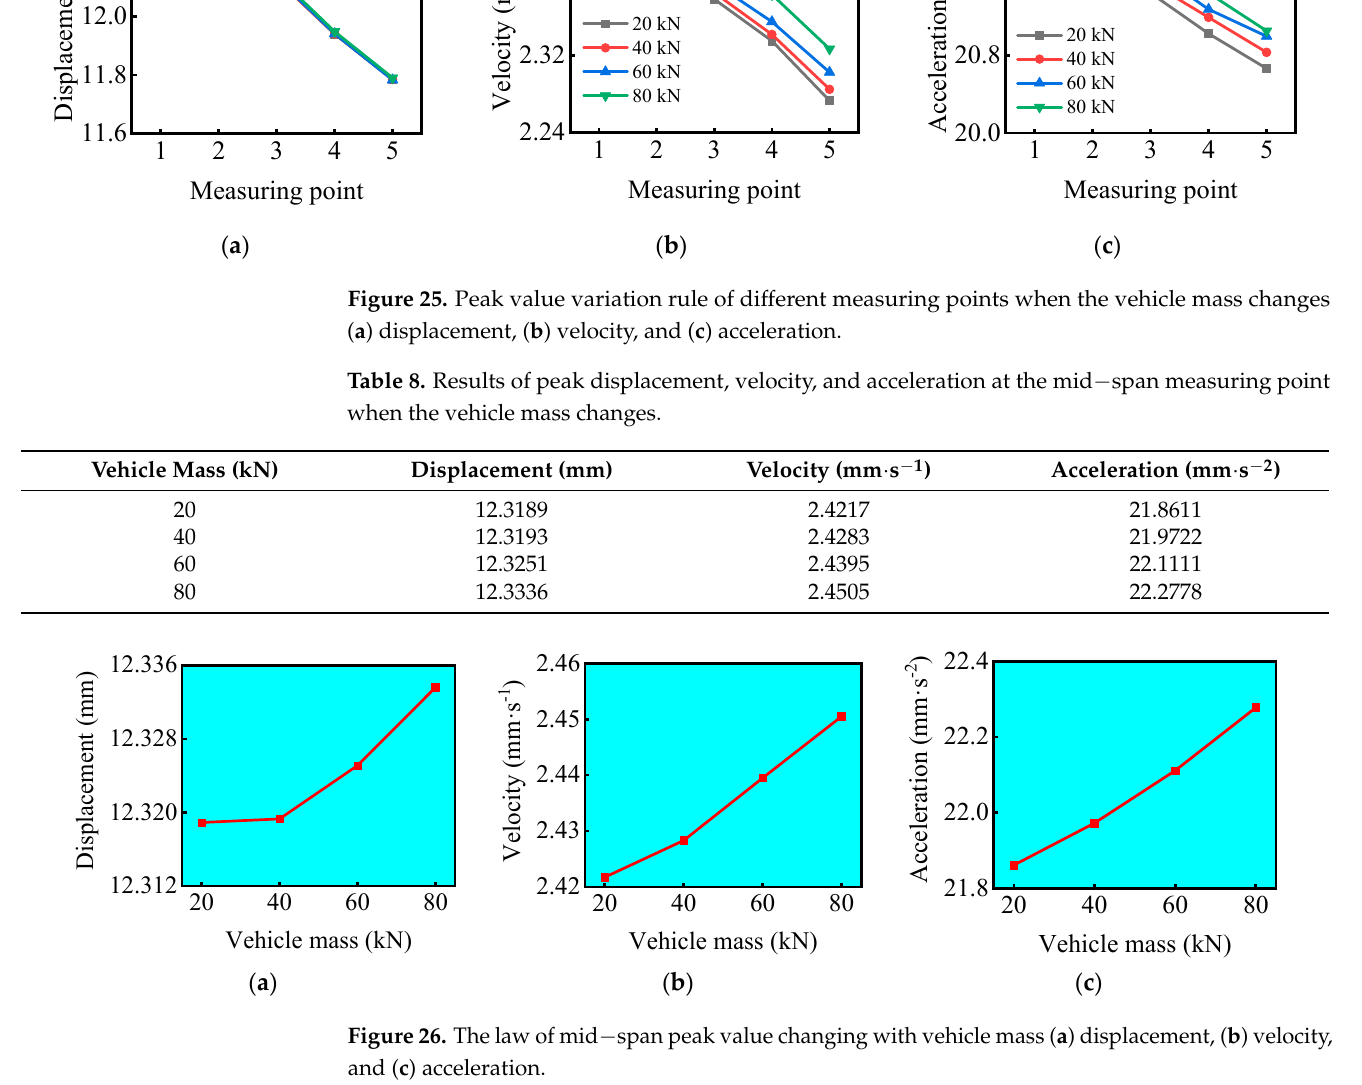
Table 8. Results of peak displacement, velocity, and acceleration at the mid − span measuring point when the vehicle mass changes.